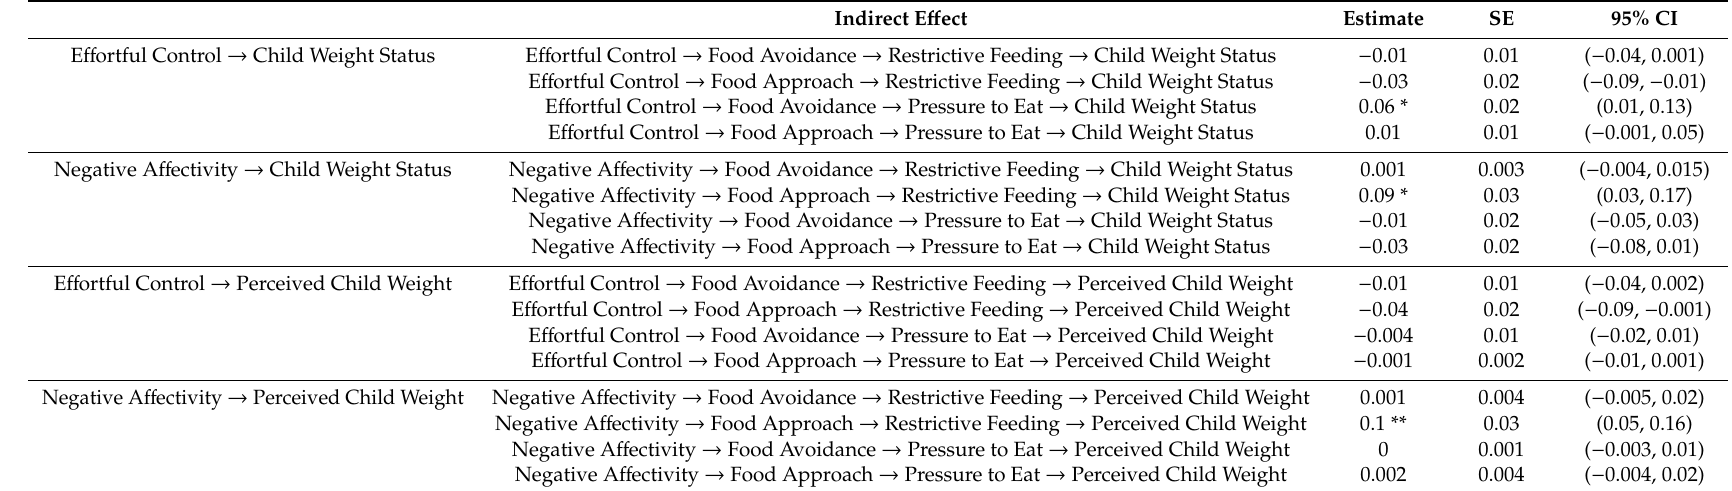
Table 2. The unstandardized indirect e ff ects between temperament and weight. Note . SE = Standard error; CI = Confidence